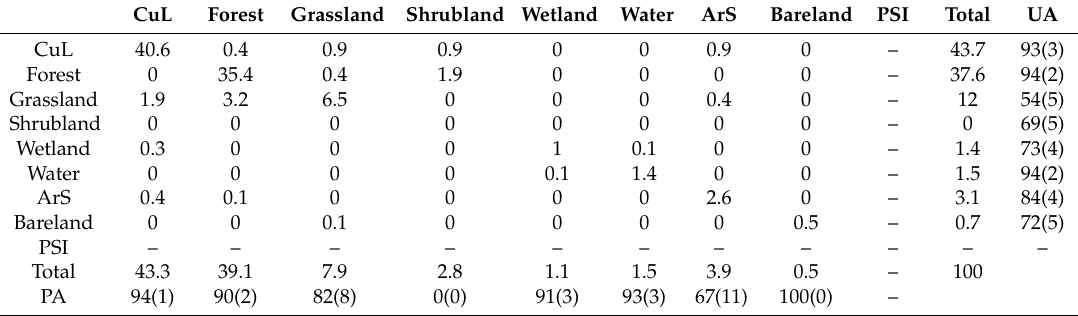
Table A10. The error matrix of estimated area proportions for R10: Overall accuracy is 88.0%